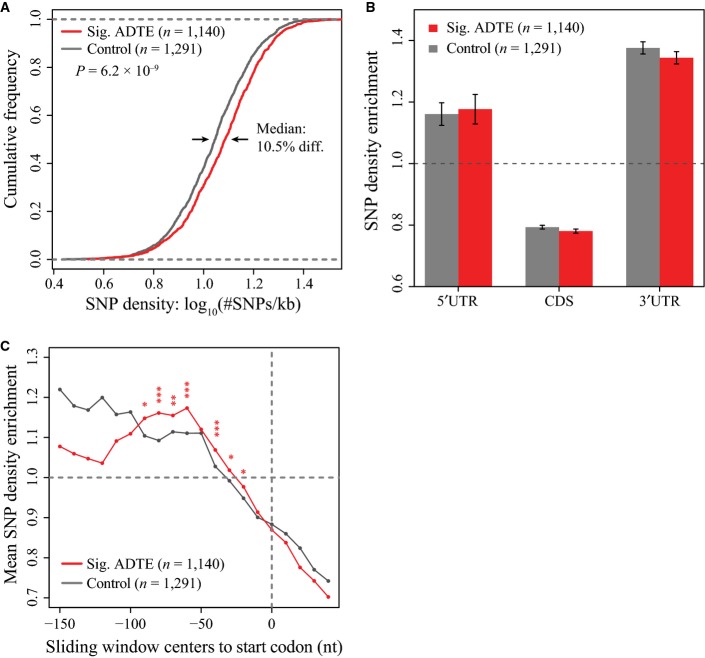
Sequence features that were correlated with ADTE, based on the polysome profiling data with ADTE cut-off = 1.5.
A–C Panels are the same as Fig3A–C, but with ADTE cut-off = 1.5. Significant differences were indicated by asterisks (*BH-adjusted P < 0.05, **BH-adjusted P < 0.01, ***BH-adjusted P < 0.001).